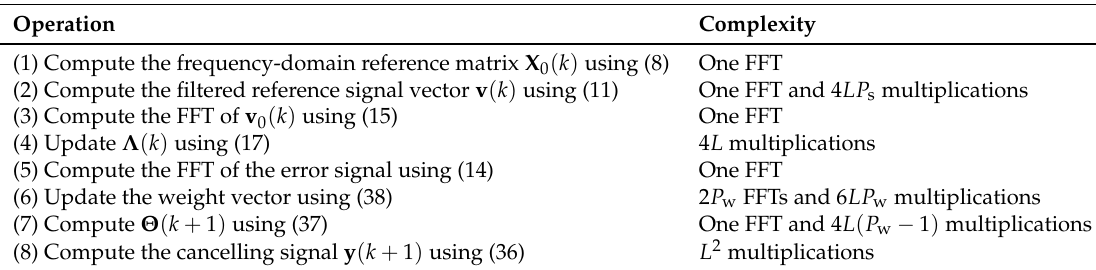
Table 6. Qiu’s delayless algorithm